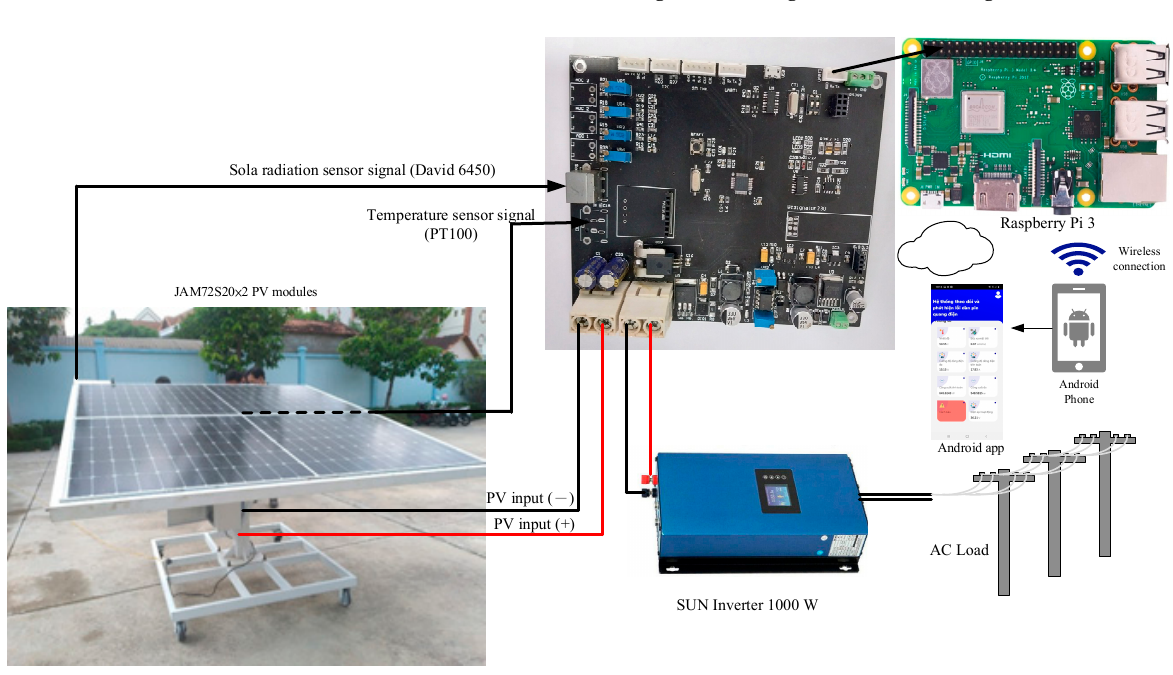
Figure 5. Setup configuration of experimental test rig. Table 2. Specifications of JAM72S20-455 PV module [30].